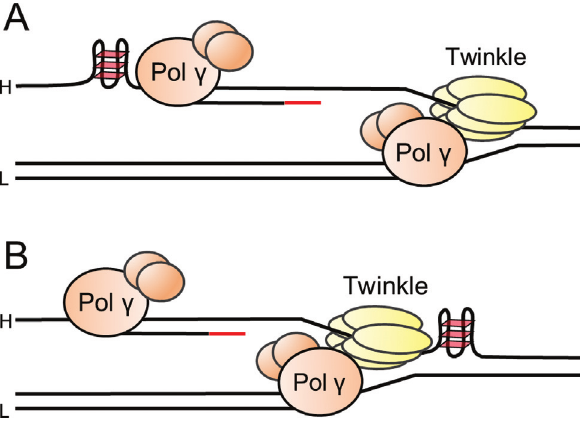
Figure 4 - Schematic representation of potential stalling of a mitochon- drial replisome at G-quadruplex structures (GQs) formed on the heavy-strand template (denoted as H). GQs (shown as three rhomboids) pose as a potential structural obstacle for the lagging-strand synthesis by Pol (cid:2) on the heavy-strand template (A), or for the Twinkle helicase during leading-strand synthesis on the light-strand template (denoted as L) (B). The red line represents the RNA primer generated at O L . Alternative prim- ing sites generated by PrimPol on the heavy-strand template (not depicted here), permit passing the obstacles and would explain the “rescue replica- tion”, as suggested by Torregrosa-Munumer et al. (2017). See text for more